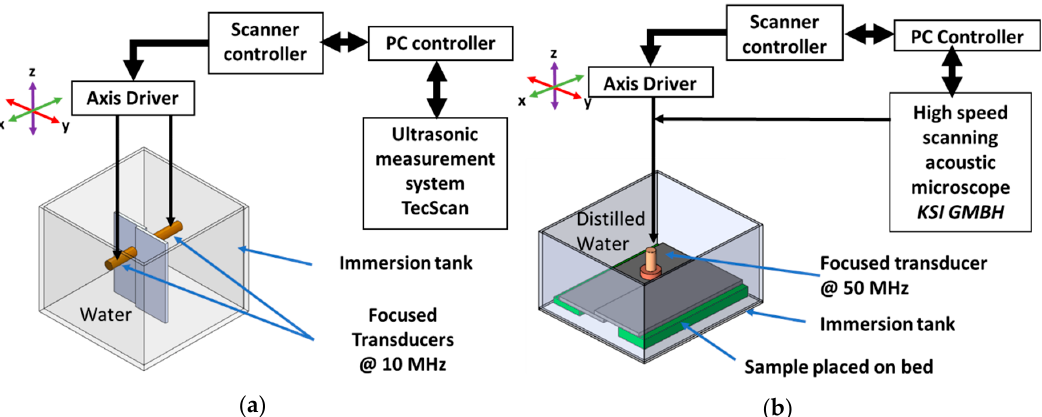
Figure 3. Experimental set-up: immersion ultrasonic non-destructive testing (NDT) with through-transmission ( a ) and scanning acoustic microscopy ( b ).